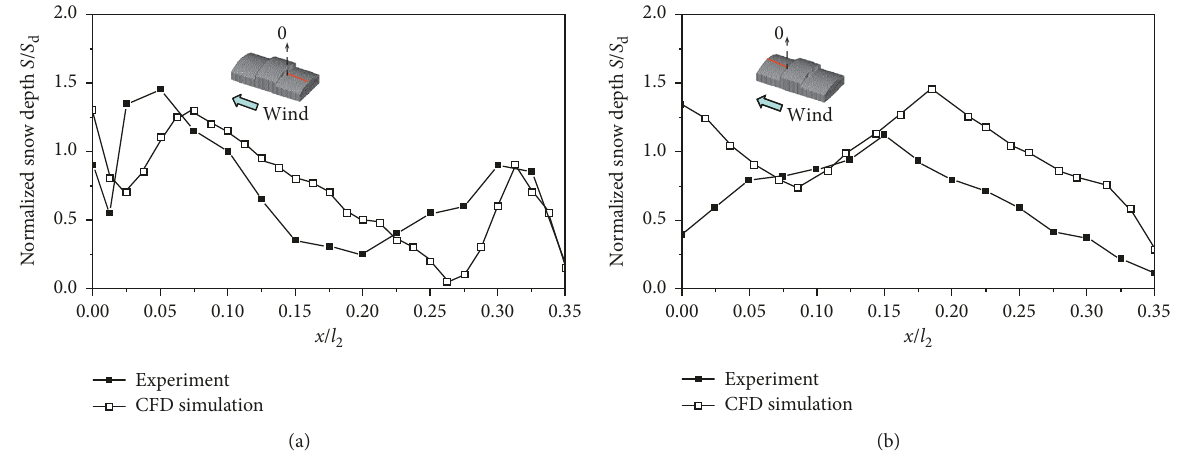
Figure 15: Comparison of results by means of experiments and CFD simulation along the central line when wind direction (a) Windward side. (b) Leeward